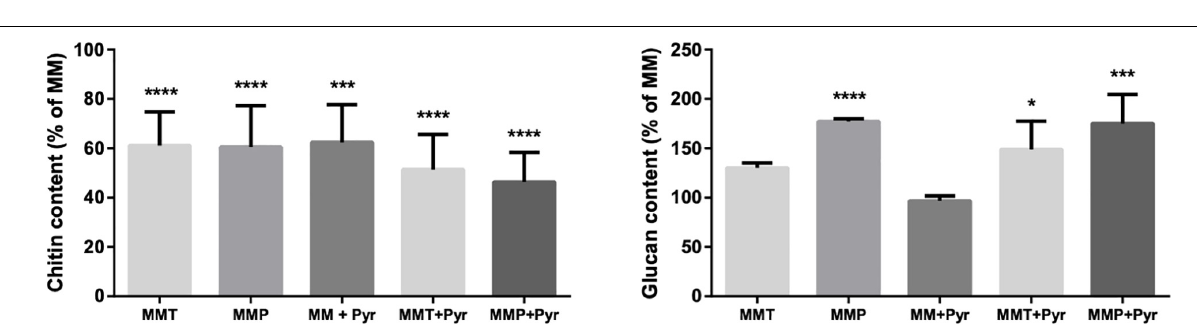
FIGURE 8 | Cell wall components levels in A. alternata grown in the presence and absence of L-tyrosine or L-phenylalanine metabolism. Chitin and β -1,3-glucan contents of A. alternata are shown. A. alternata was cultivated in liquid cultures for 3 days with alternating 8-h light and 16-h dark periods. Results are the mean ± standard errors of the means (SEMs) of triplicates of three independent experiments (Analysis of variance was performed by One-way ANOVA and followed by Tukey multiple comparison test, Prism): * P < 0.05; *** P < 0.001; **** P <